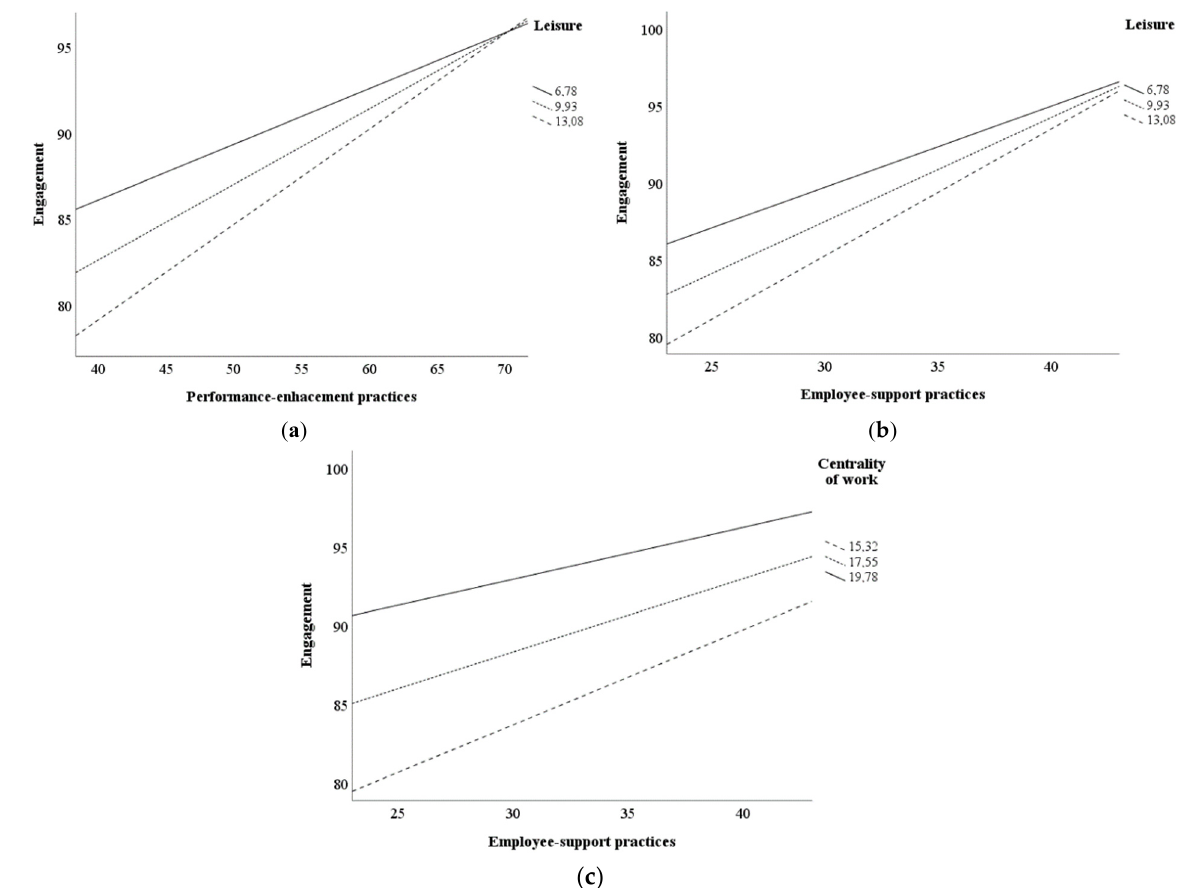
Figure 1. HRP-PWE moderations to predict work engagement. Note. In Figure 1, three interaction diagrams are observed. Diagram ( a ) shows the variation in the leisure main effect and the interaction of this dimension with HRP-P. In diagram ( b ), there is variation in leisure’s main effect and the interaction of this dimension with HRP-S. Finally, in diagram ( c ), a variation of main effects in HRP-S and centrally of work and the interaction of HRP-A and centrality of work is observed.